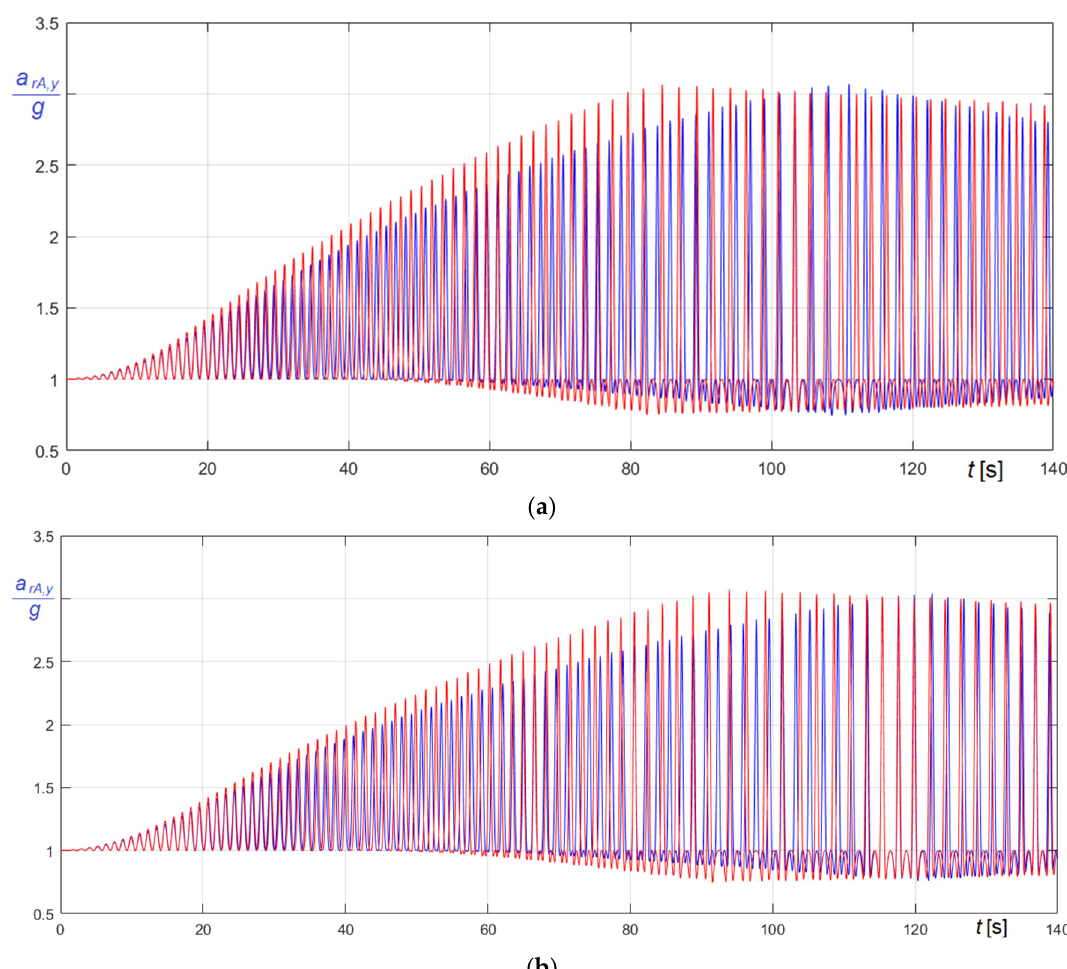
(cid:3028) (cid:3293)(cid:3250),(cid:3300) a rA , y − t curves in A in the transient phase (red curves in the undamped case, − (cid:1872) curves in (cid:1827) in the transient phase (red curves in the undamped Figure 25. Comparison of Figure 25. Comparison of g (cid:3034) blue curves in the damped case): ( a ) M e 1 forcing function (Equation (74)); ( b ) M e 2 forcing function case, blue curves in the damped case): ( a ) (cid:1839) (cid:3032)(cid:2869) forcing function (Equation (74)); ( b ) (cid:1839) (cid:3032)(cid:2870) forcing (Equation (75)). Appl. Sci. 2020 , 10 , x FOR PEER REVIEW function (Equation (75)).